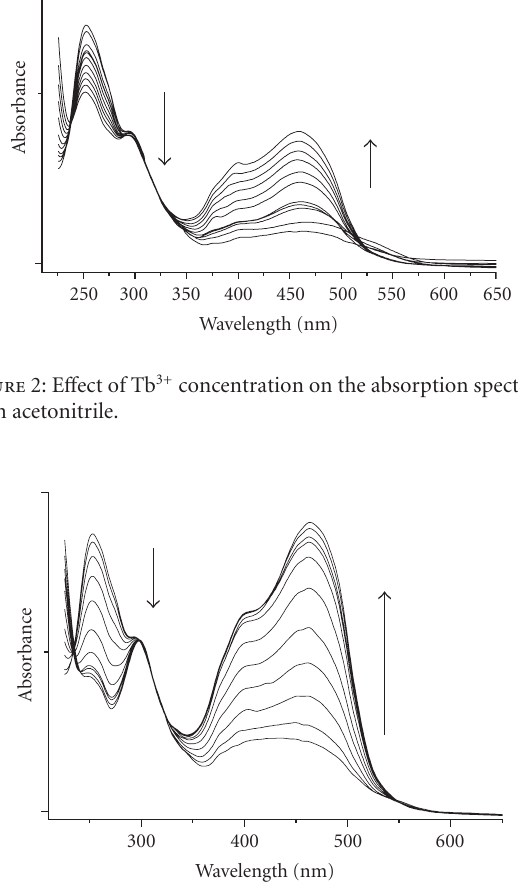
Figure 3: E ff ect of Sm 3+ concentration on the absorption spectra of SP in